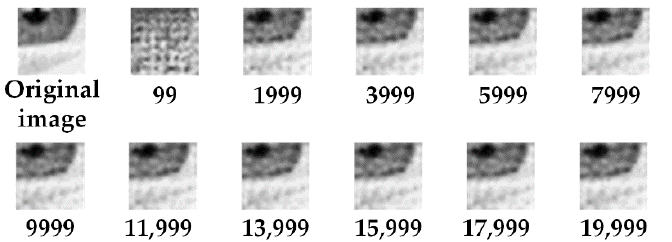
Figure 9. Some images generated by DPAP with a measurement rate of 0.1 at different number of iterations.